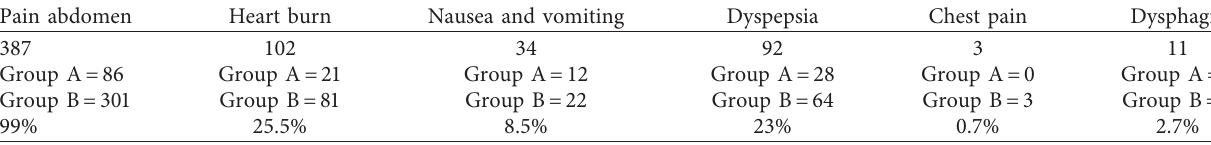
Table 2: Preoperative symptoms in all symptomatic cholelithiasis patients.